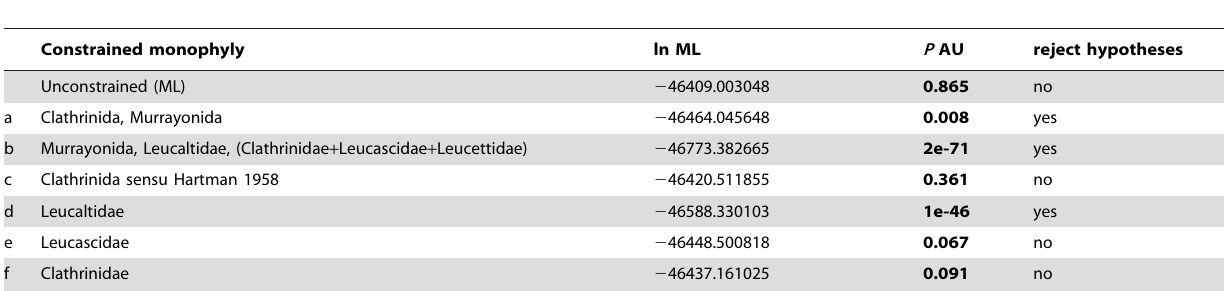
Table 4. p-values for the approximately unbiased test [47] for different topological constrains in Calcinea.